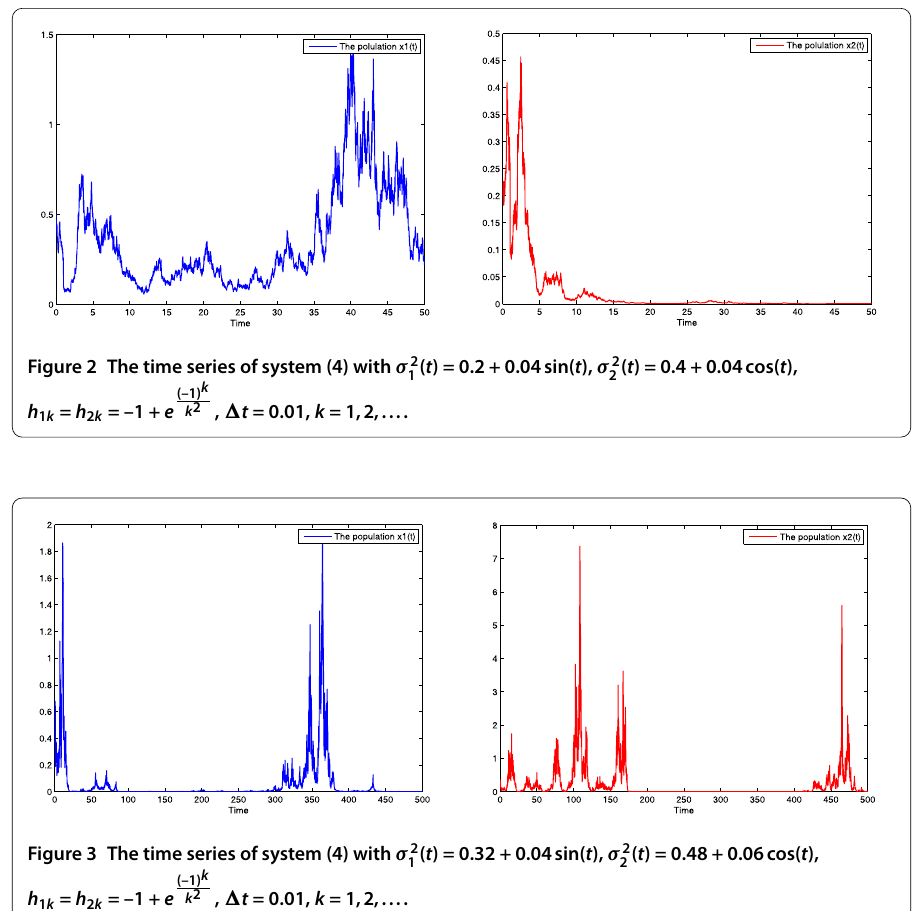
Figure 3 The time series of system (4) with σ 2